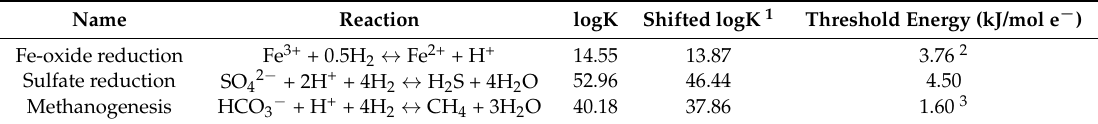
Table 3. Stoichiometry of TEAP reactions implemented in Models 1, 2, and 3 and optimal threshold energy values